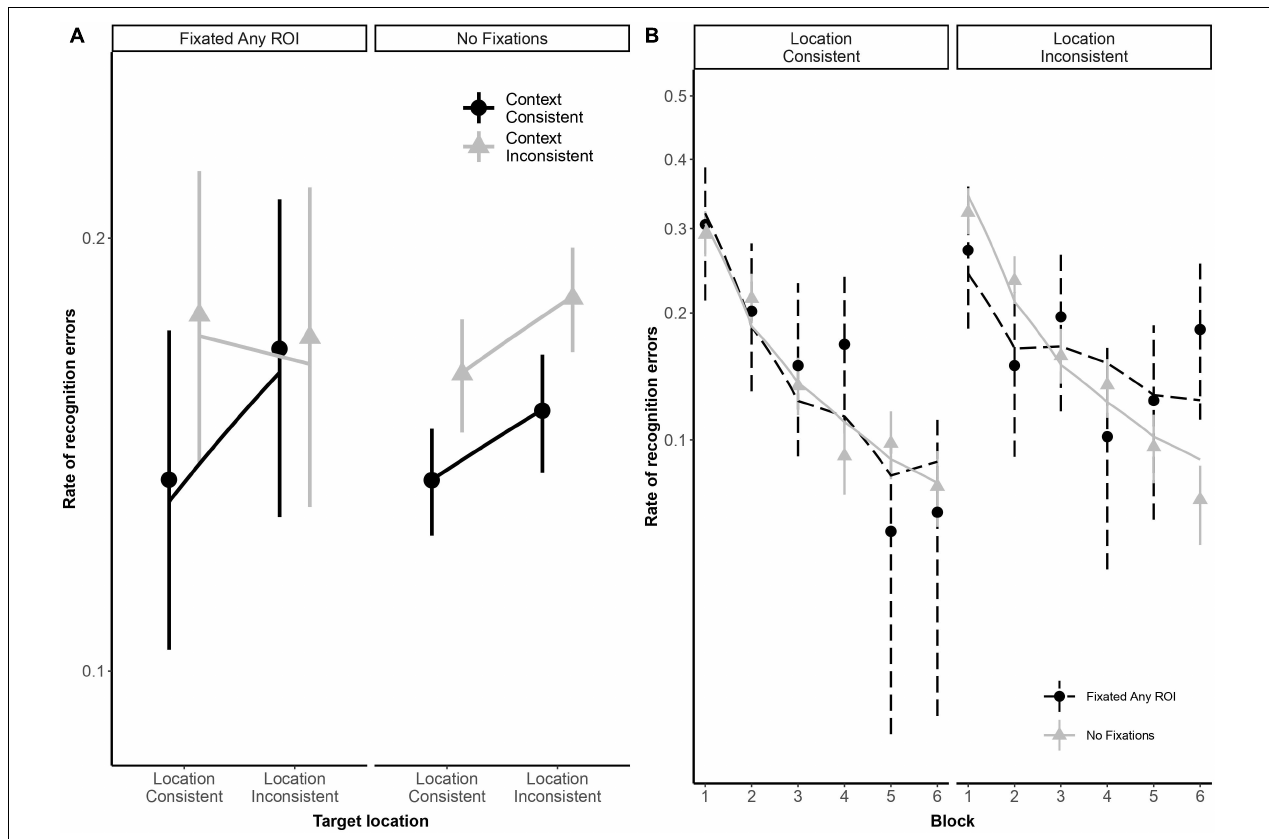
FIGURE 3 | Panel (A) shows subject-weighted mean recognition error rate as a function of context and location consistency in trials where participants looked at any of the three regions of interest (ROI), depicted by the “FixatedAnyROI” facet, compared to trials in which looking-at-nothing behavior did not emerge. Panel (B) shows subject-weighted mean recognition error rate as a function of repetition (i.e., blocks) and location consistency. In both panels, the y -axis is logit-scaled to match logistic regression error analyses. Point ranges represent bootstrapped confidence intervals, and lines represent logistic regression model